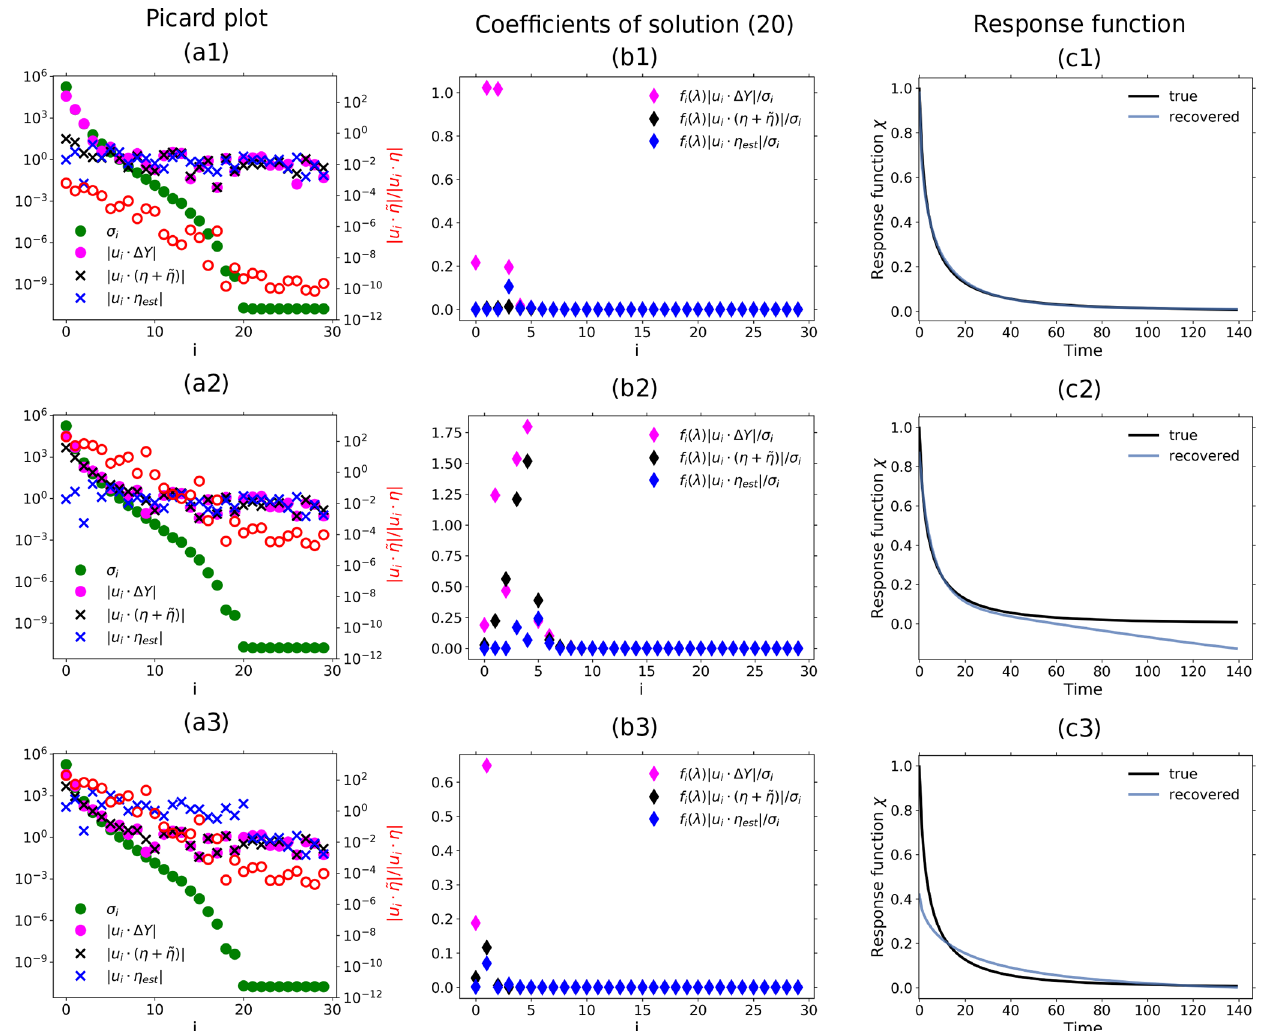
Figure 8. Demonstration of how nonlinearities affect the recovery of the response function: (a) Picard plot; (b) coefficients of regularized solution (Eq. 20) and (c) recovered linear response function. First row: nonlinearity factor a = 10 − 10 (no monotonicity check); second row: nonlinearity factor a = 2 . 5 × 10 − 4 (no monotonicity check); third row: nonlinearity factor a = 2 . 5 × 10 − 4 (with monotonicity check). The noise is overestimated in the low-frequency spectrum in the third row because nonlinearities yield a derived χ(t) that does not obey the monotonicity constraint. As a consequence, the method increases the level of low-frequency components until the monotonicity constraint is obeyed. The failure to obey the monotonicity constraint and consequent large overestimation of noise in this case can be taken as an indication of the presence of nonlinearities in the response. Note that the “true” linear response function in this nonlinear case a (cid:54)= 0 is obtained analytically from the linear case a = 0 via Eq. (41) (see Appendix D). The regularization parameter determined by the algorithm is λ ≈ 3120 for the first row, λ ≈ 74 for the second, and λ ≈ 14611873 for the third. For more details, see the